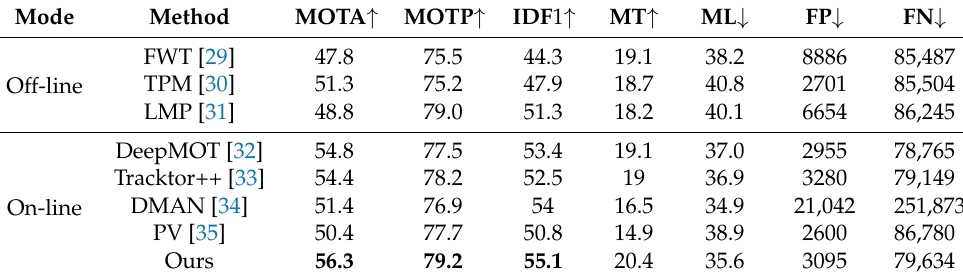
Table 1. Comparison of our algorithm with other state-of-the-art